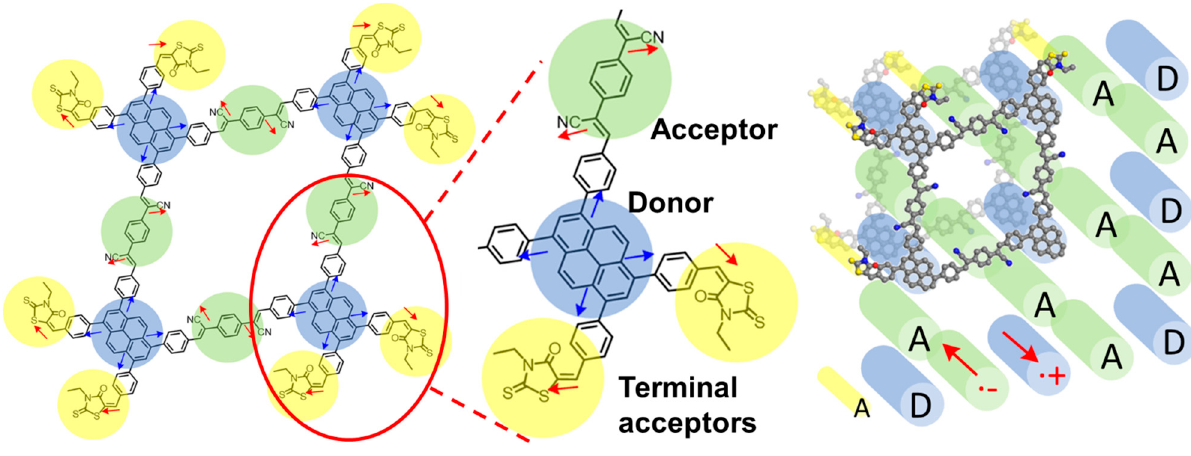
Figure 5. Structure of sp 2 c-COF ERDN [26] containing D-A units and paths for electrons and holes through the π -stacking interactions.